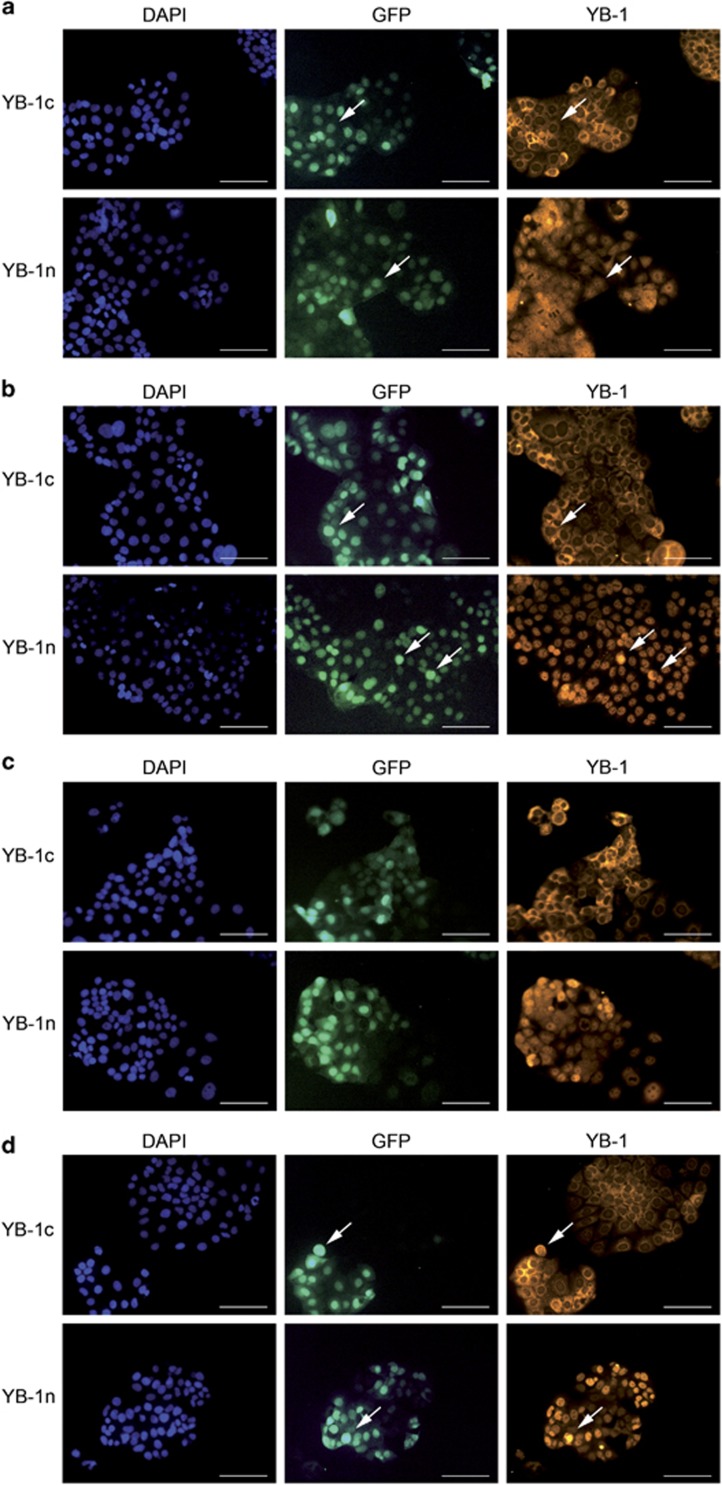
Immunofluorescence of cultured Caco2 cells showing staining of YBX1n and YBX1c after 24 h (a), 48 h (b), 72 h (c) and 96 h (d) of doxycycline (2 μg/ml) treatment. DAPI: nuclear stain, GFP: RAS expression, YB-1: cytoplasmic YBX1c and nuclear YBX1n. Arrows indicating nuclear YBX1n and cytoplasmatic YBX1c stainings (a) and enhancement after RAS induction (b,d). Scale bar: 100 μm.